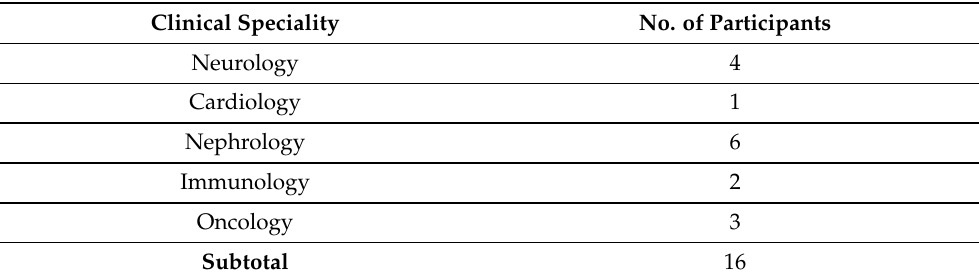
Table 1. Participant demographics by clinical